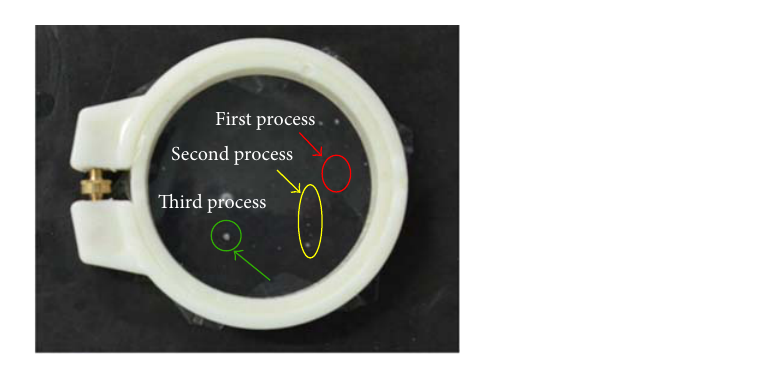
Figure 4: Morphologies of laser induced damage on FEP film.